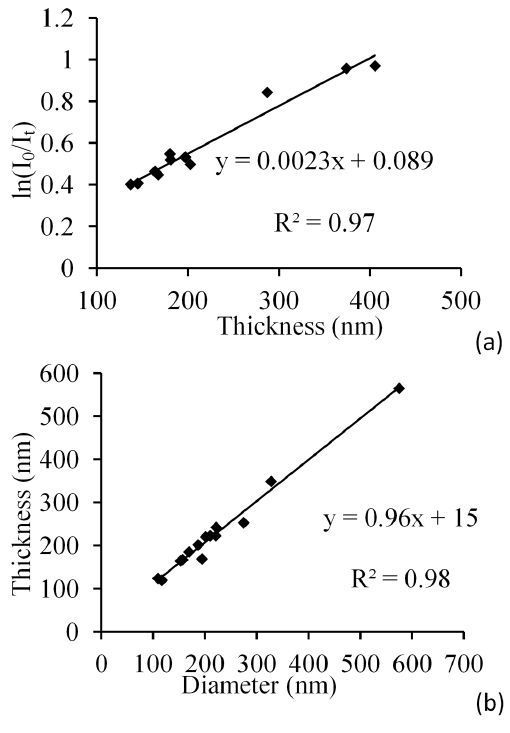
Fig. 9. (a) Experimental data of ln( I 0 / I t ) versus t for absorption coefficient ( α) from two samples and their linear fitting with equa- tion and square of the correlation coefficient R 2 . (b) The calcu- lated thickness versus measured diameter of amorphous carbona- ceous spheres and their linear fitting with equation and square of the correlation coefficient R 2 . The slope close to 1 indicates their thickness is comparable to their diameter.